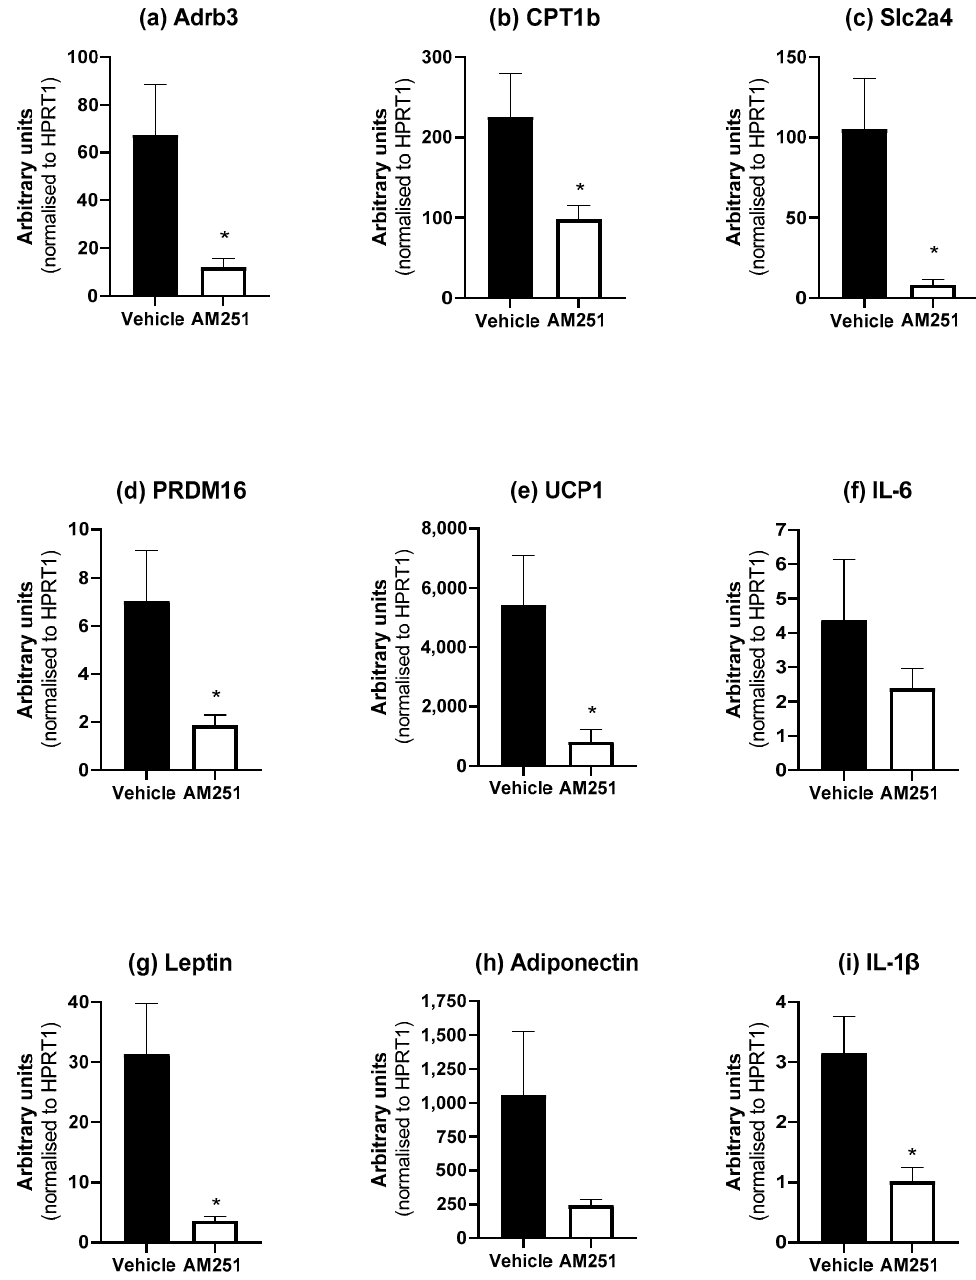
Figure 5. Effect of AM251 treatment in HFD rats on BAT mRNA expression. HFD rats were injected daily with either AM251 (3 mg/kg of body weight, ip) or vehicle for six weeks. All results are presented as a mean ± SEM in arbitrary units (normalised to housekeeping gene HPRT1) from n = 6–10 (AM251) and n = 9 (vehicle) treated rats on an HFD. Significance * p ≤ 0.05 compared to